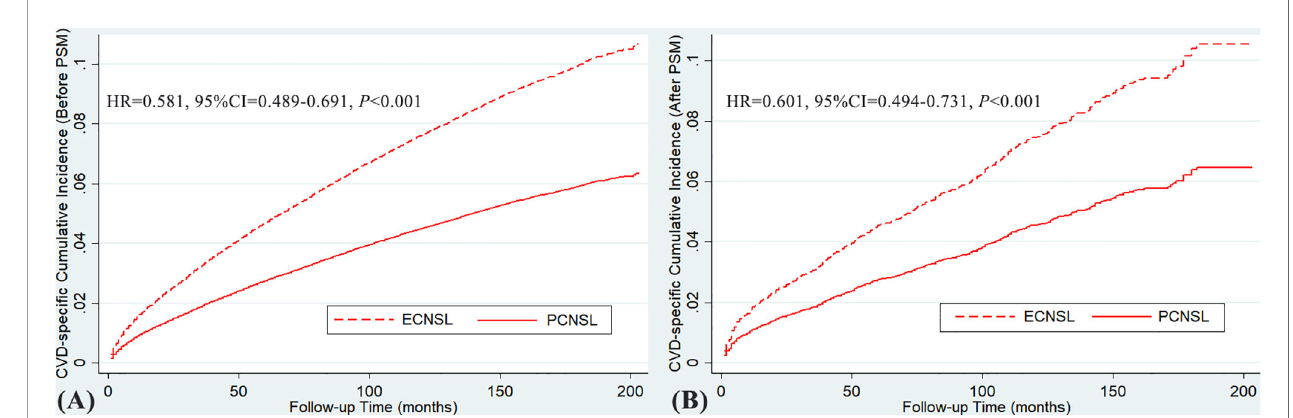
FIGURE 6 | (A) CVD-speci fi c cumulative incidence over time in PCNSL and ECNSL before PSM. (B) CVD-speci fi c cumulative incidence over time in PCNSL and ECNSL after PSM. (Before PSM: HR = 0.581, 95% CI = 0.489 – 0.691, P < 0.001; after PSM: HR = 0.601, 95% CI = 0.494 – 0.731, P <